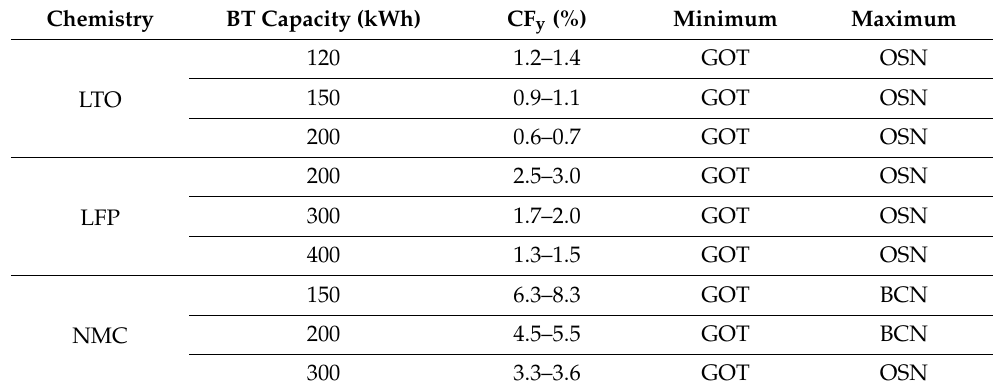
Table 11. Summary of CF y results due to the sensitivity to the battery capacity.